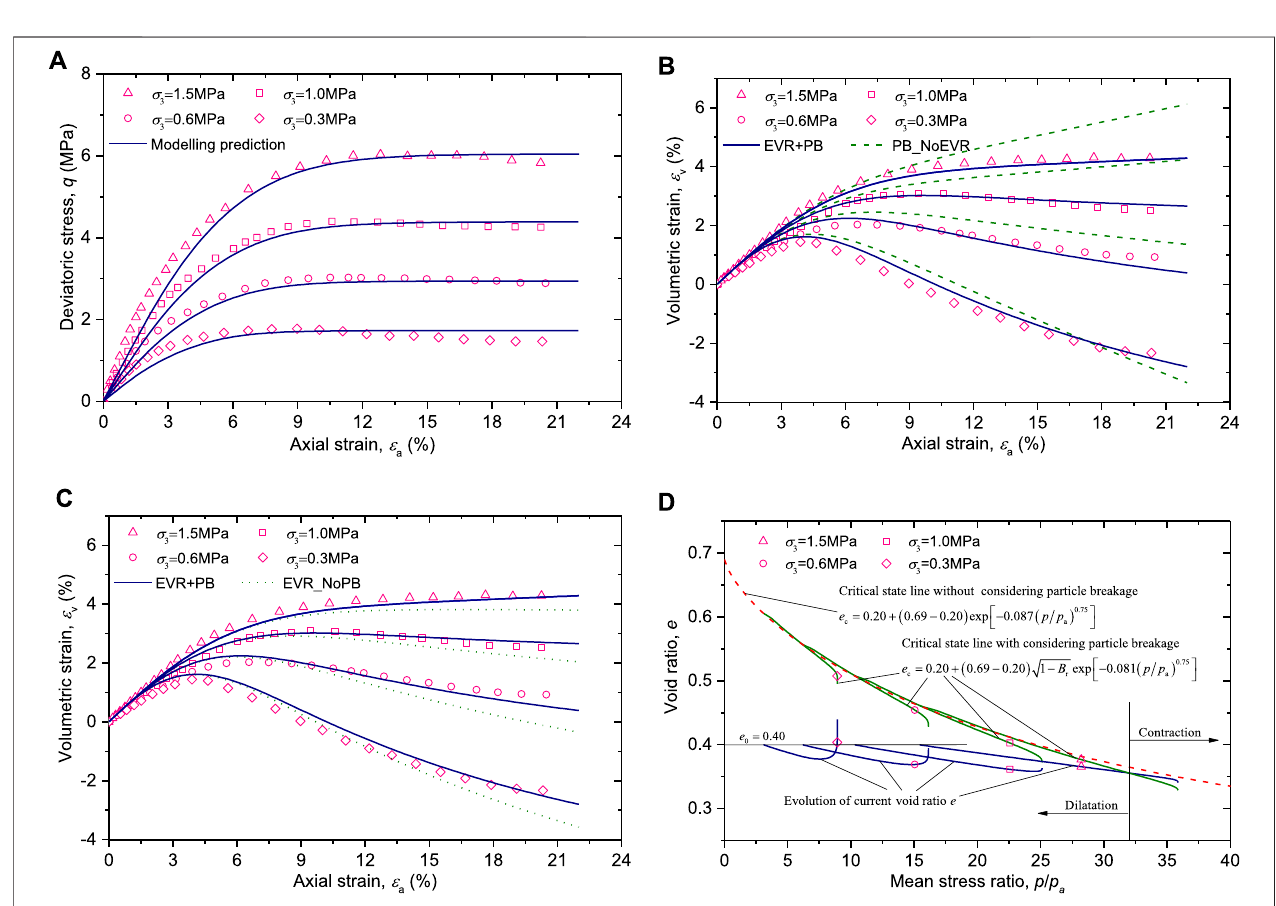
FIGURE 1 | Model predations and experimental results of the Hekouchun rock fi ll (test data were from [21]).